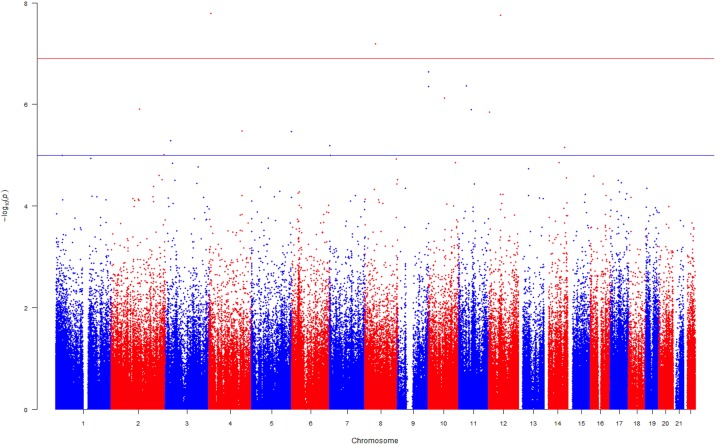
A Manhattan plot indicating the associations between DBP and DNA methylation in European men.The plot demonstrates the associations between DBP and DNA methylation in European men. The model was adjusted for confounders, estimated cell counts and principal components. The uncorrected–log10(p-values) are plotted on the y-axis. The blue line is drawn to separate the CpG sites that surpassed p-value<1×10−05, the threshold suggestive of an association and the red line to separate the CpG sites that surpassed the Bonferroni threshold (p-value<1.24×10−07). The CpG sites that surpassed the Bonferroni threshold were considered to be associated with the trait.